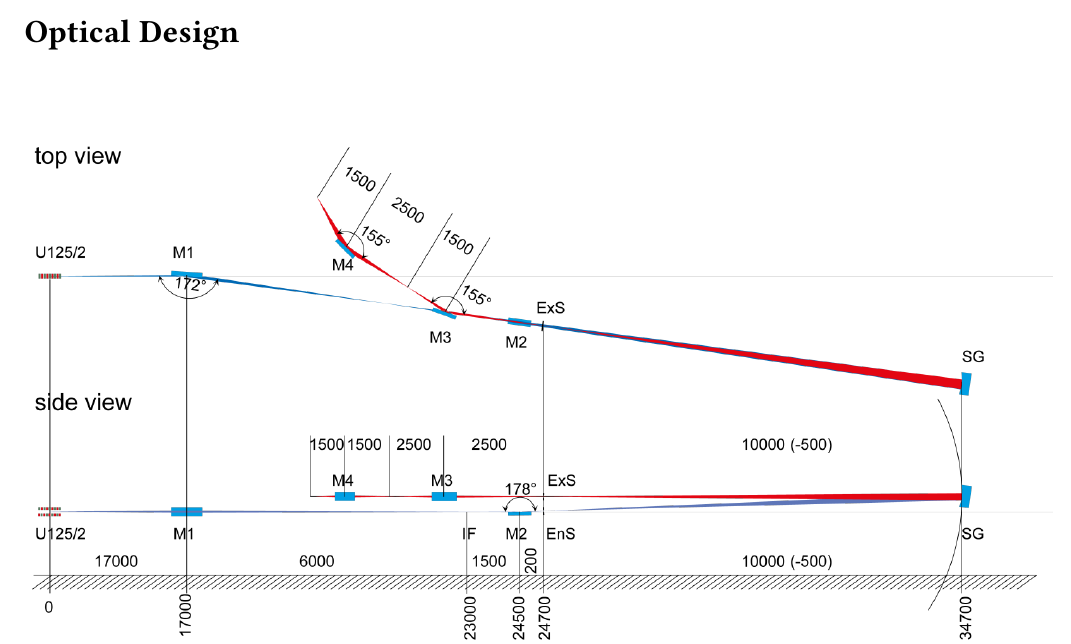
Figure 2: Optical design of beamline U125-2 NIM. All distances are given in mm. The optical elements are described in Table 2.